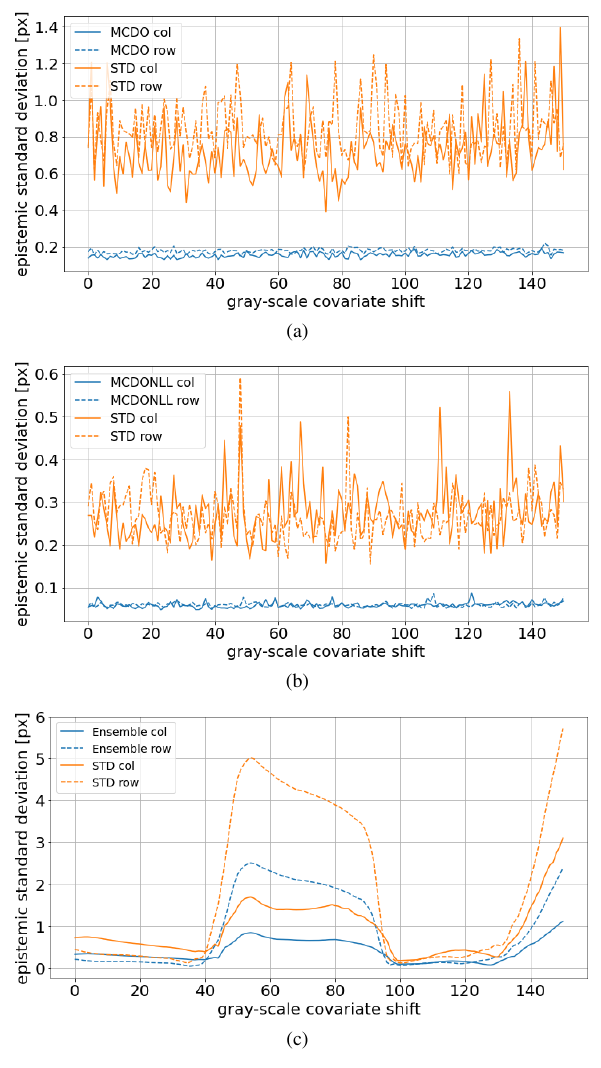
Figure 7. Epistemic standard deviation estimates in image columns and rows in pixel units with (a) MCDO, (b) MCDONLL and (c) Ensemble under covariate shift in case of interpolation.